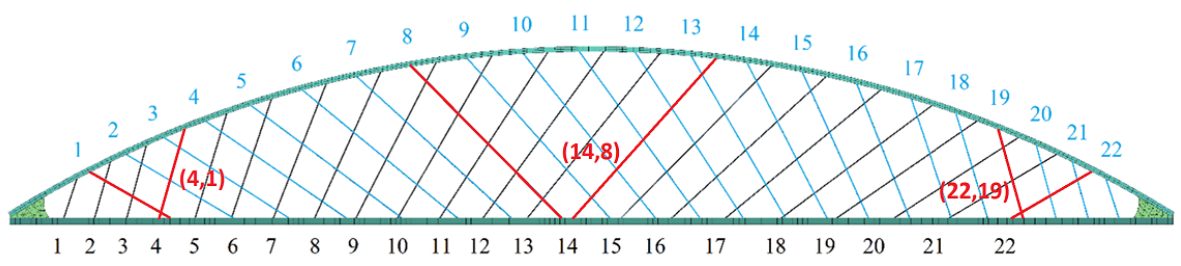
Figure 22: Examples of rupturing two nearest hangers.